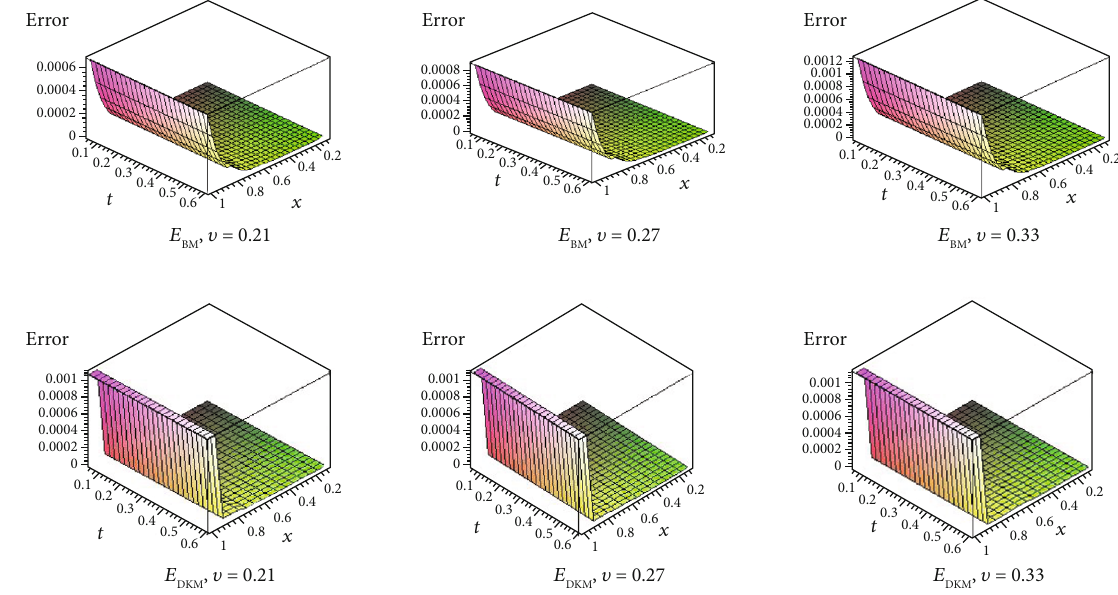
Figure 11: The values of errors by B-by-BM and DKM at T = 0 : 6 , N = 20 , and k = 2 for υ = 0 : 21, 0 : 27, 0 : 33 .